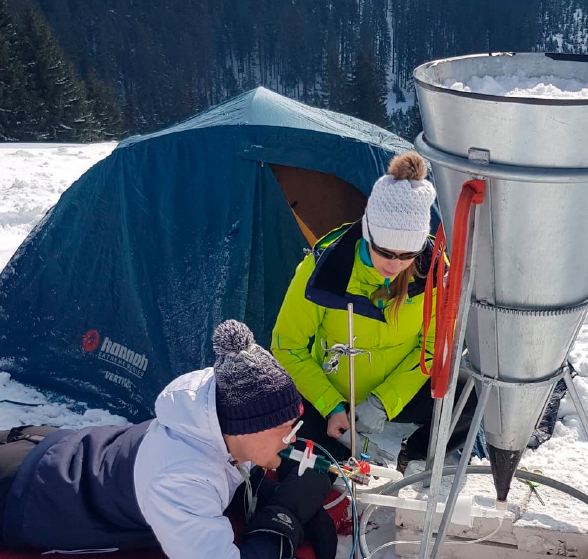
Figure 2. A photo from the stabilization phase of the experiment. Subject is in a prone position, lying on an insulated mat, breathing through a mouthpiece connected to a monitor. The specially de- signed tubing is ready to be connected to the cone-shaped container filled with material simulating avalanche snow. The subject is monitored closely by the attending